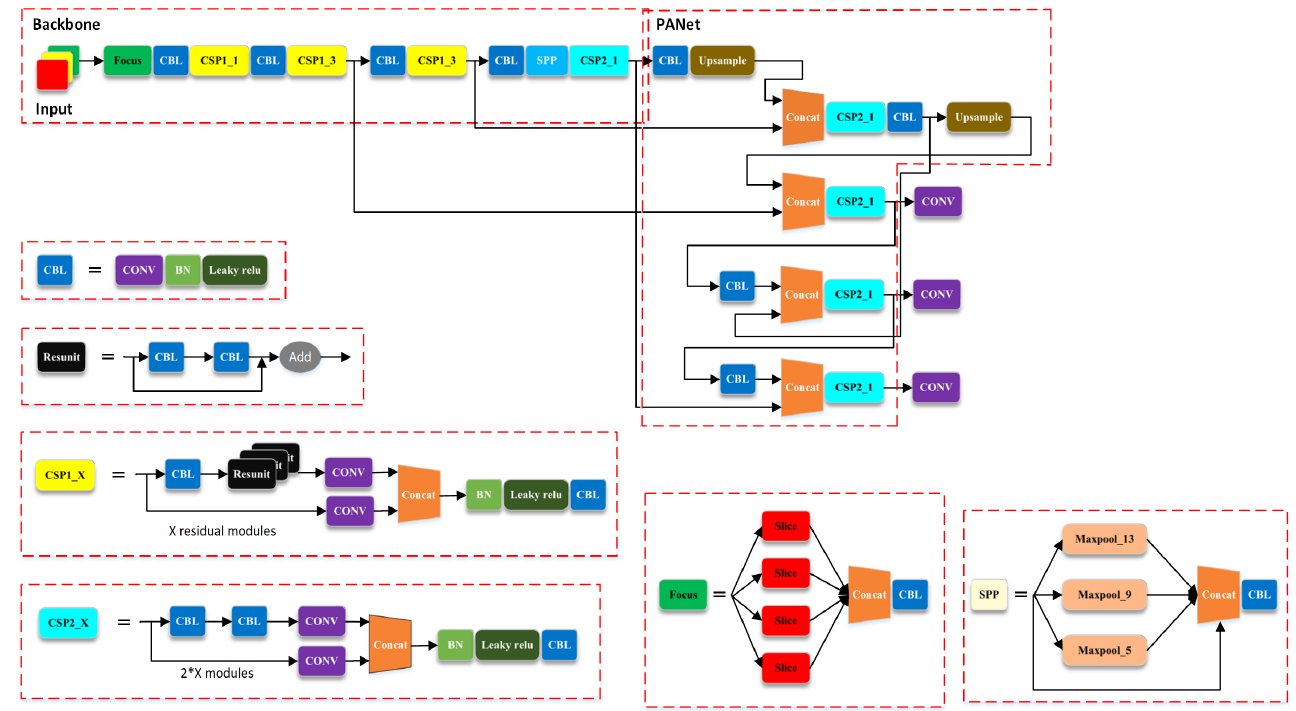
Figure 1. The network structure of